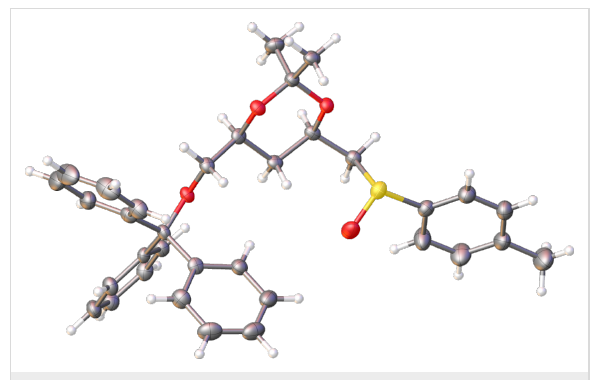
Figure 3: Single crystal X-ray structure of compound 4